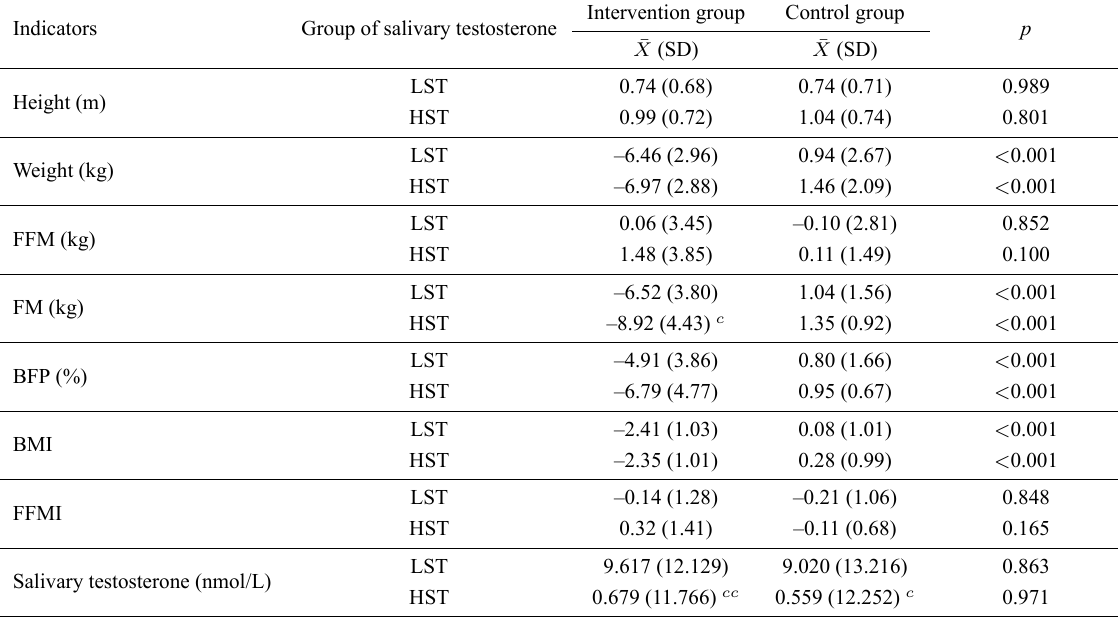
Table 3. Changes of body composition in different salivary testosterone